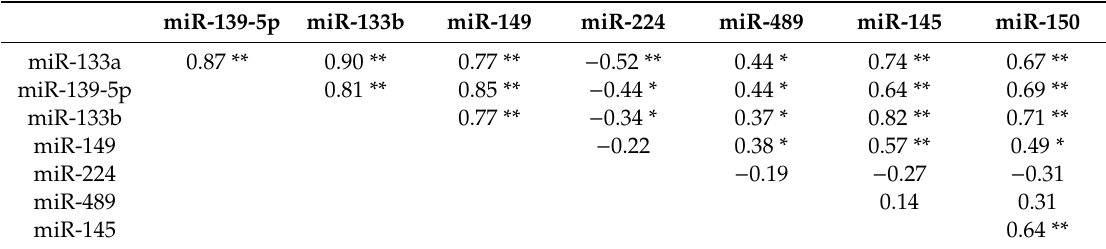
(Table S1: List of 21 deregulated miRNAs identified by array and gene targets anti-expressed identified by